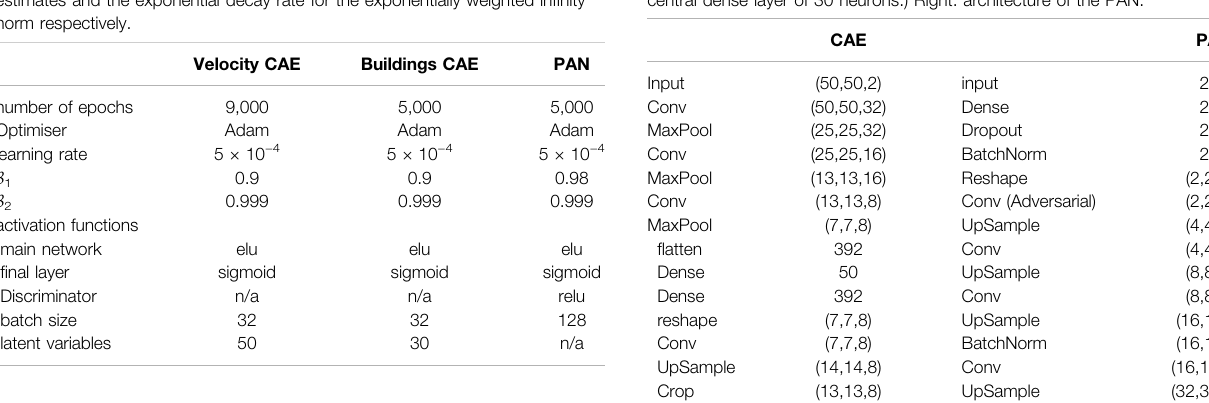
TABLE 2 | Left: architecture of the CAE for the velocity fi eld. (The architecture of the CAE for the buildings fi eld is similar, but with an input of (50,50,1) and a central dense layer of 30 neurons.) Right: architecture of the PAN.